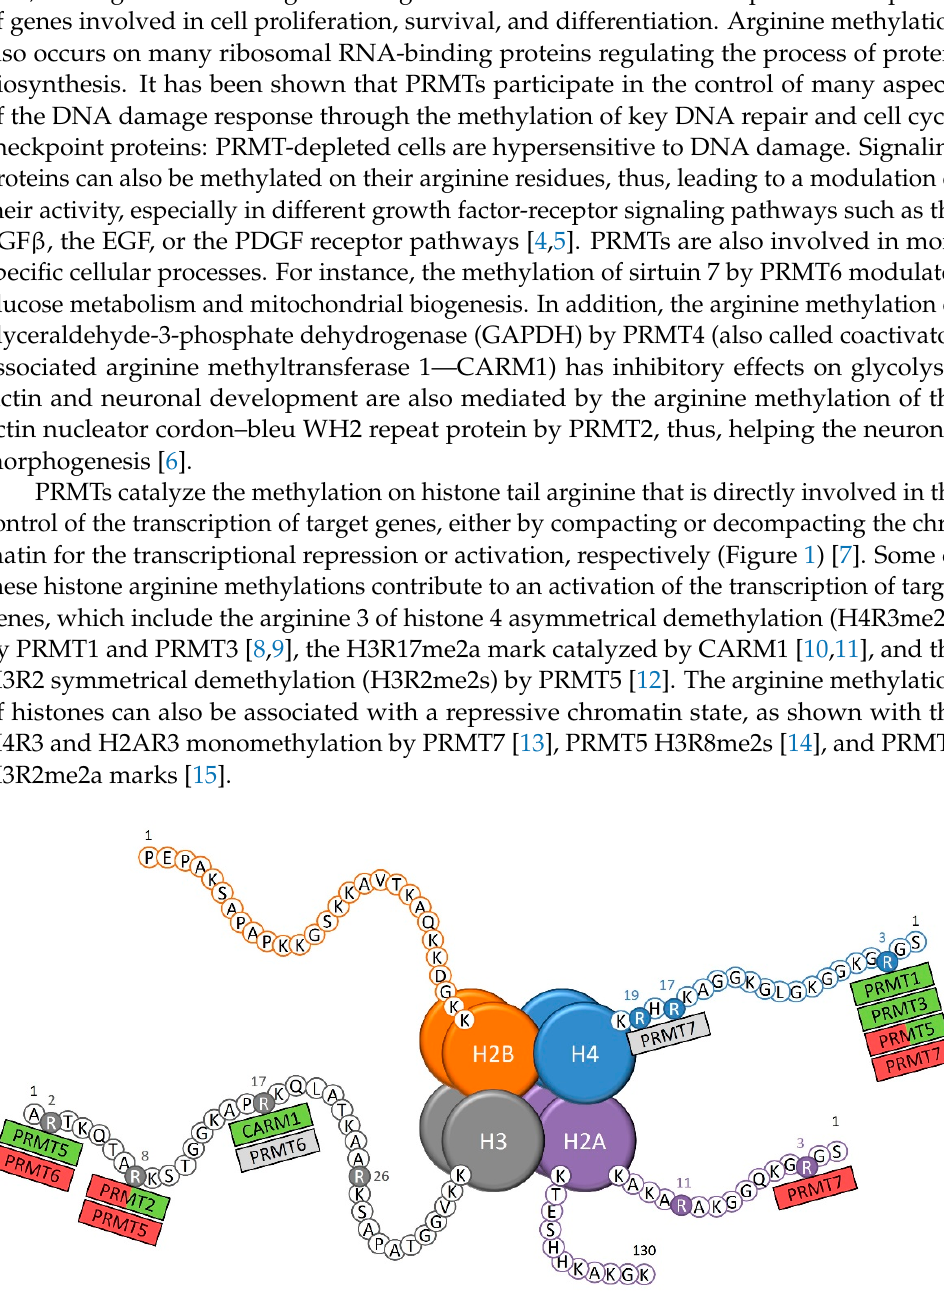
Figure 1. The known sites of arginine methylation on histone tails by protein arginine methyltrans- ferases (PRMTs). Green: transcriptional activation; red: transcriptional repression; grey: unknown role on